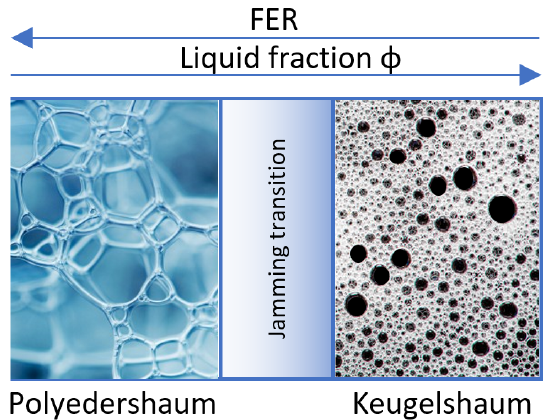
Figure 3. Scheme of foam aspects for different liquid volume fractions φ . Φ = 36% corresponds to a FER = 2.7—from Langevin [26].